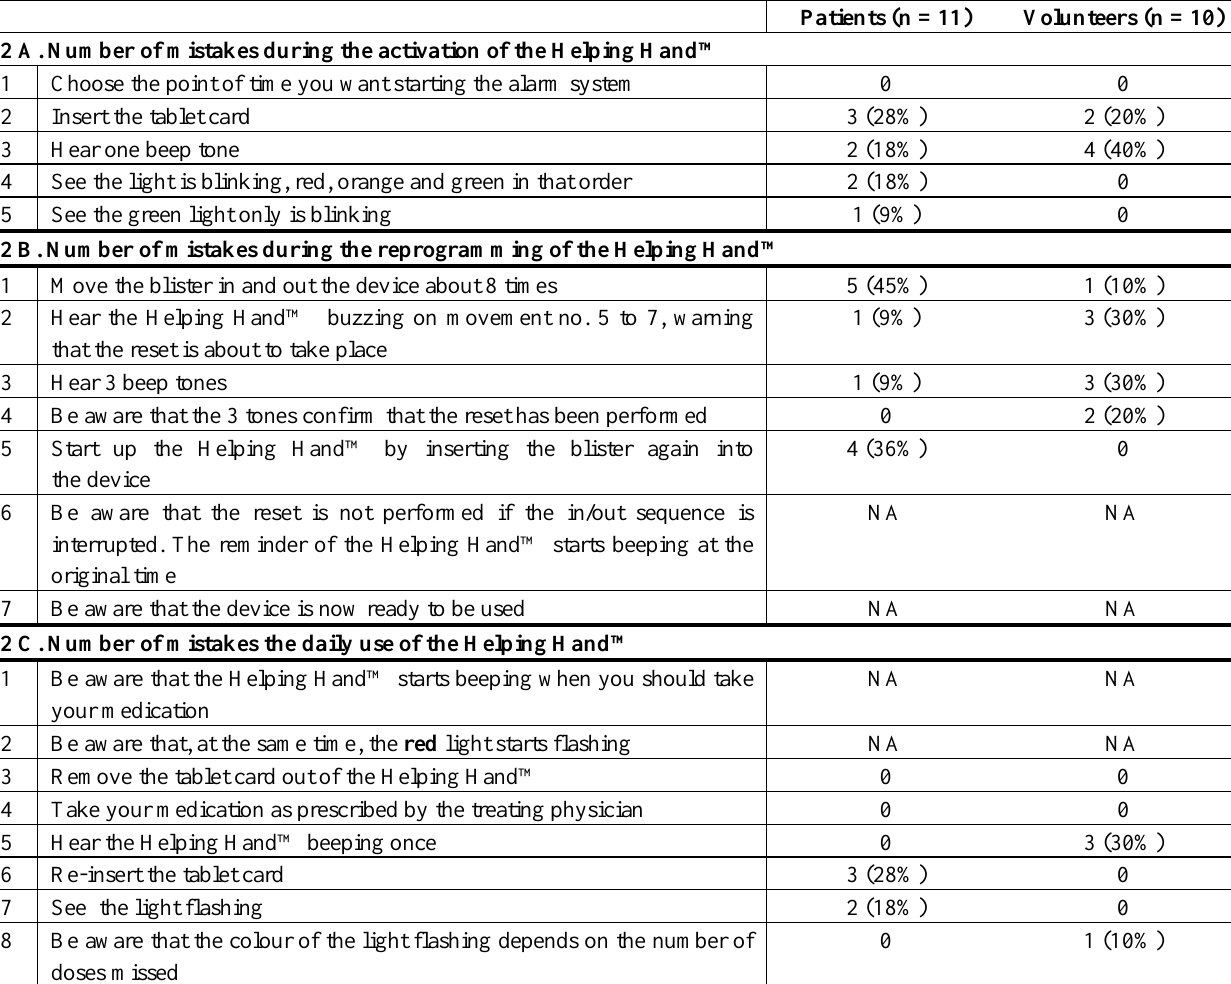
Table 2. Number of mistakes during the use of the Helping Hand TM